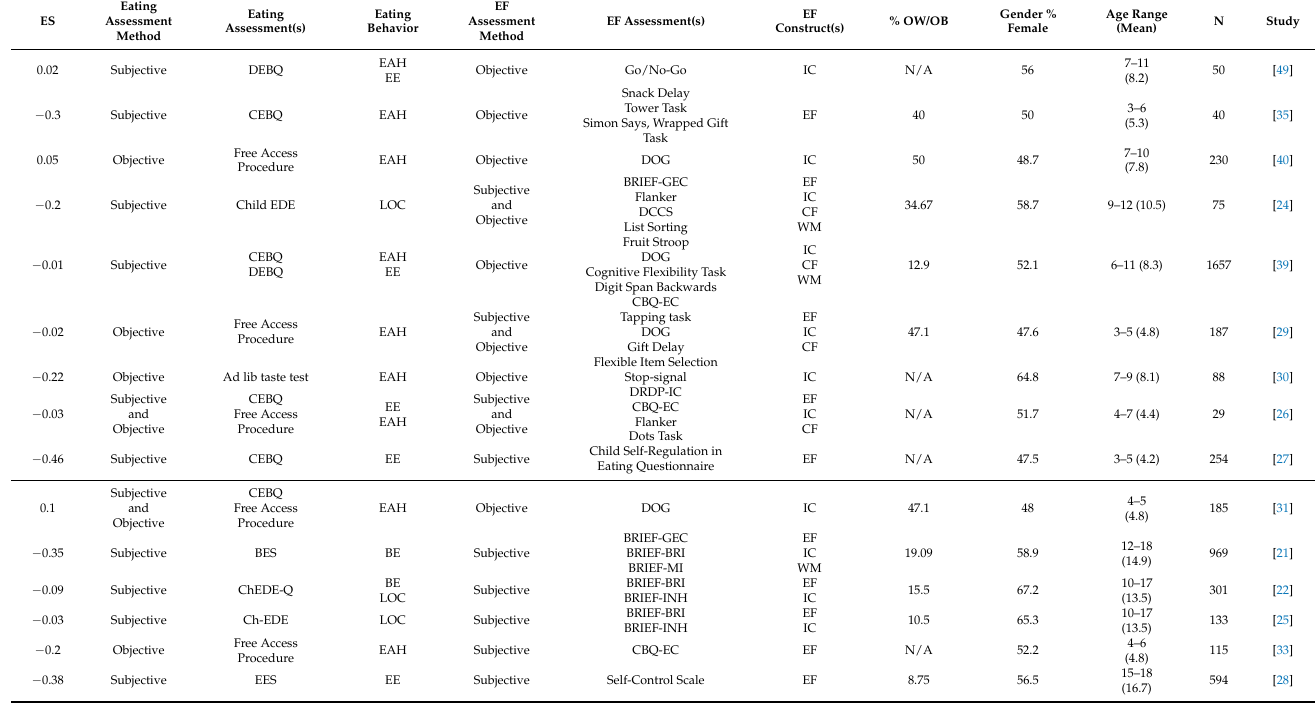
Table 1. Descriptive characteristics of included studies in the